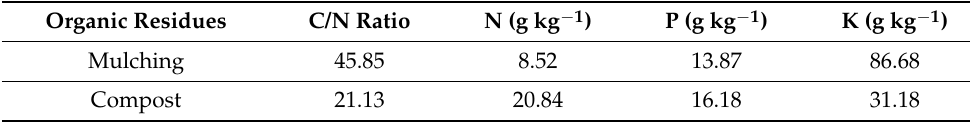
Table 2. Chemical composition (N, P and K) of the organic residues used in the field experiment. Values are given as mean (n =